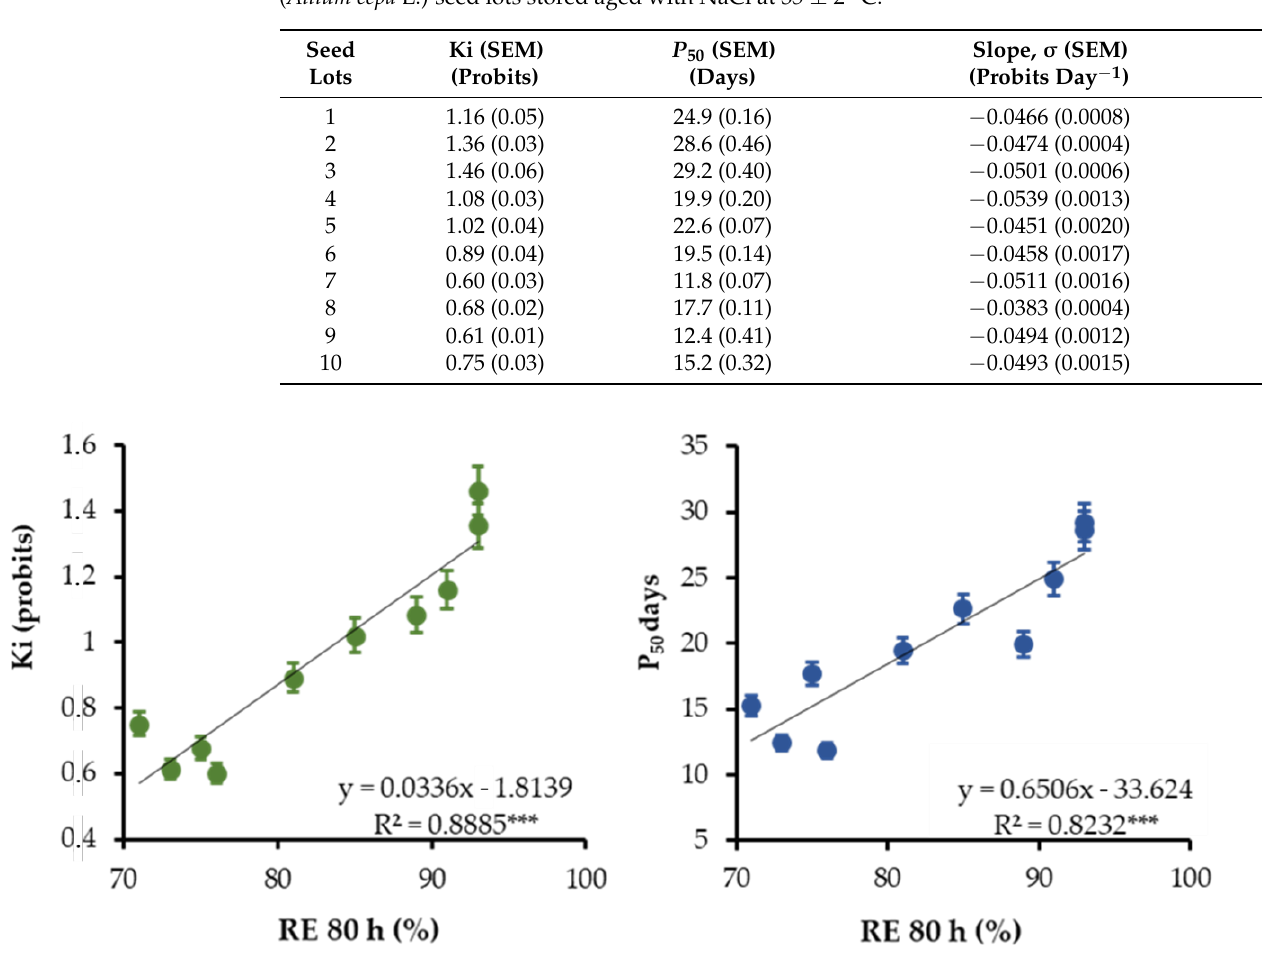
Figure 3. Correlation between radicle emergence (RE; % of seeds sown) at 80 h and storage parameters, Ki and P 50 , for seeds of ten onion ( Allium cepa L.) seed lots. Values were derived from Tables 1 and 2. Significance: ***: 0.001.